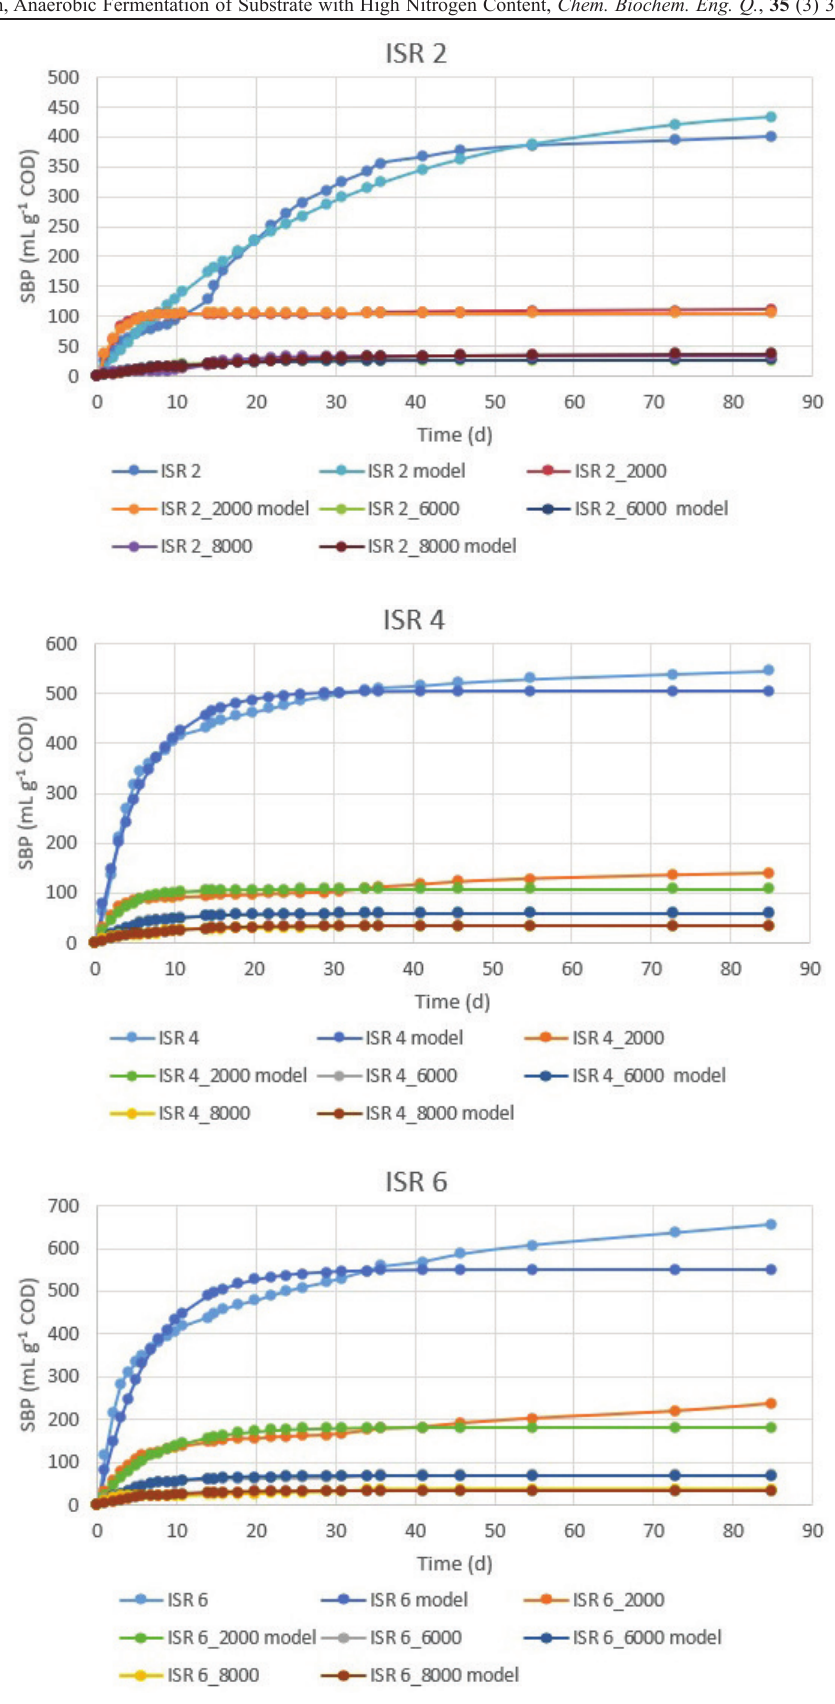
Fig. 2 – Experimental values and calculated values (model) of biogas production according to first order kinetics at different ISR ratios and ammonia nitrogen